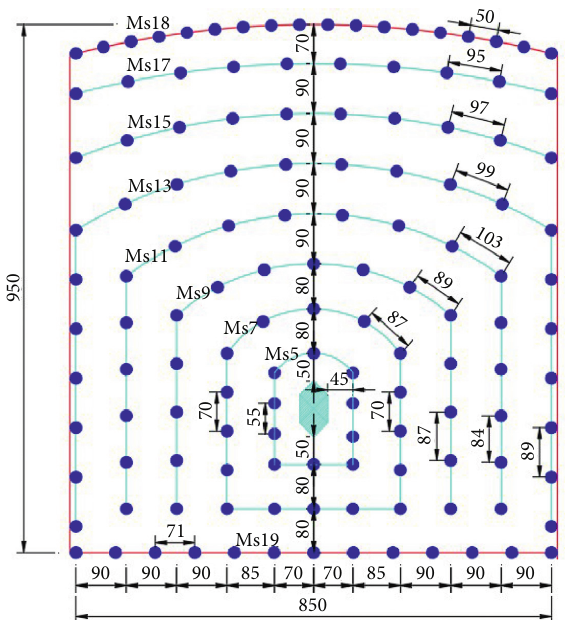
Figure 3: Schematic diagram of the design hole layout of the pilot tunnel blasting in the first floor. Table 1: Detonator delay time parameter.